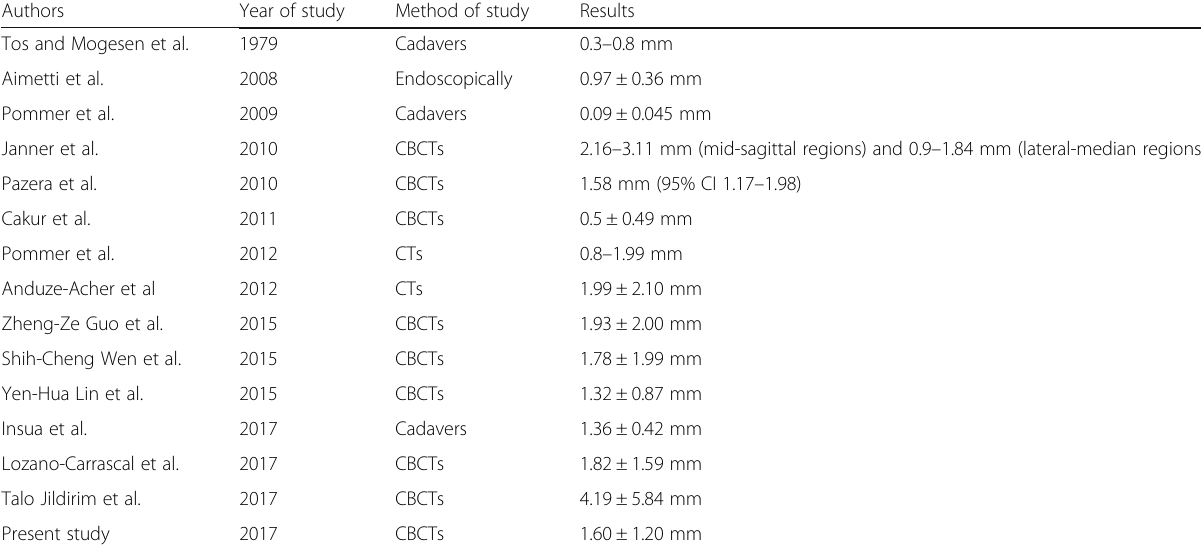
Table 7 All studies measuring the thickness of the Schneiderian membrane [5, 7, 9, 12, 15, 17 –